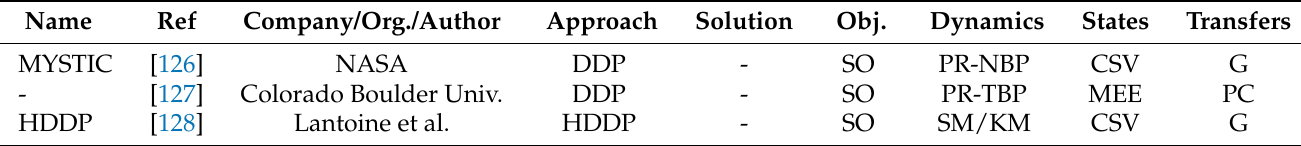
Table 4. Representative Tools Implementing Dynamic Programming for Low-Thrust Trajectory